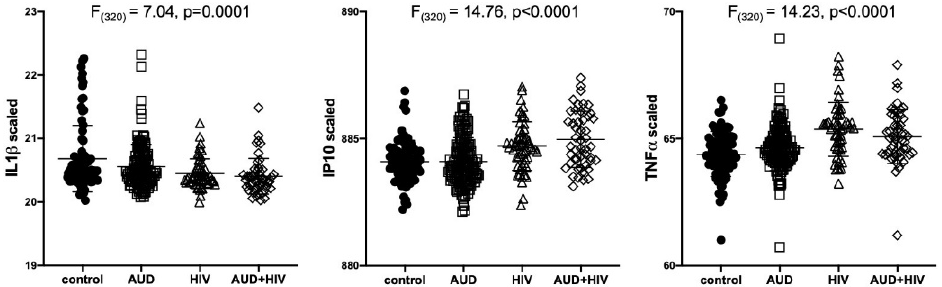
Figure 1. Levels of soluble proteins by initial diagnoses. Relative to the control group, IL1 β levels were low in the AUD ( p = 0.02), HIV ( p = 0.0004), and AUD+HIV ( p = 0.0001) groups. Relative to the control group, IP10 and TNF α levels were high in the HIV and AUD+HIV groups (both p < 0.0001). IL1 β : Interleukin (IL)1 β ; IP10: Interferon γ -induced Protein 10 (IP10); TNF α : Tumor Necrosis Factor α ; black circles: healthy controls; open squares: Alcohol Use Disorder (AUD); open triangles: Human Immunodeficiency Virus (HIV); open diamonds: AUD+HIV.